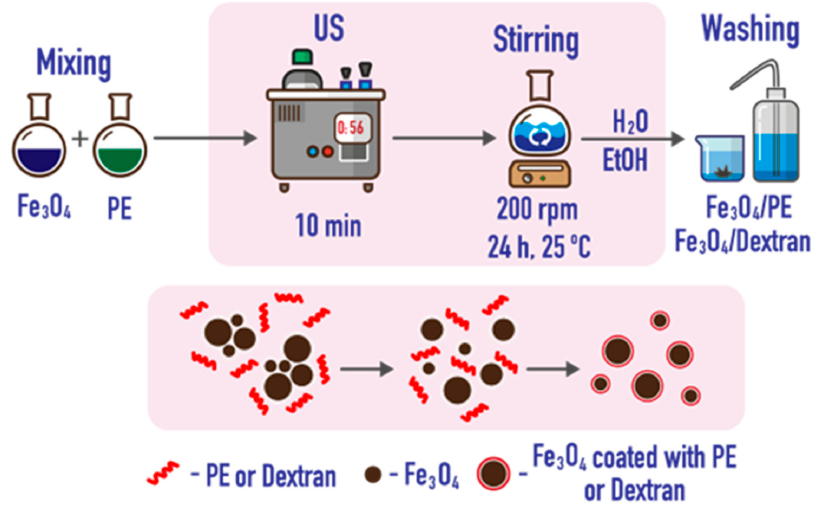
Figure 11. A scheme of modification of IONs with polyelectrolytes (PE) and dextran.